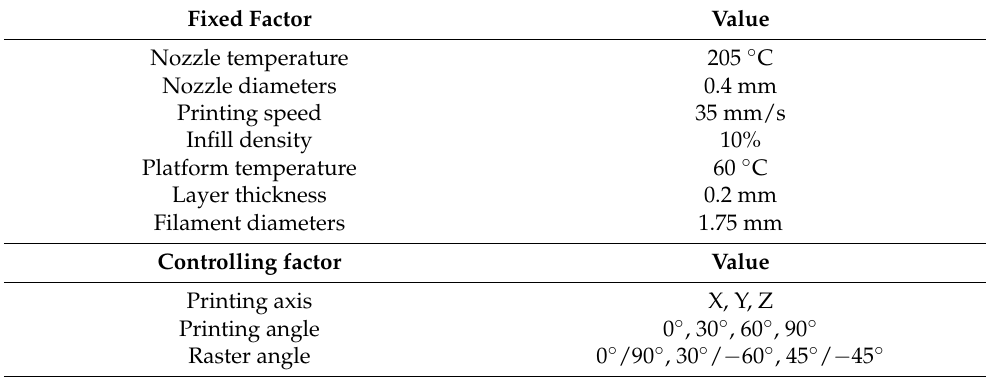
Table 1. The fixed and controlling factor of FDM